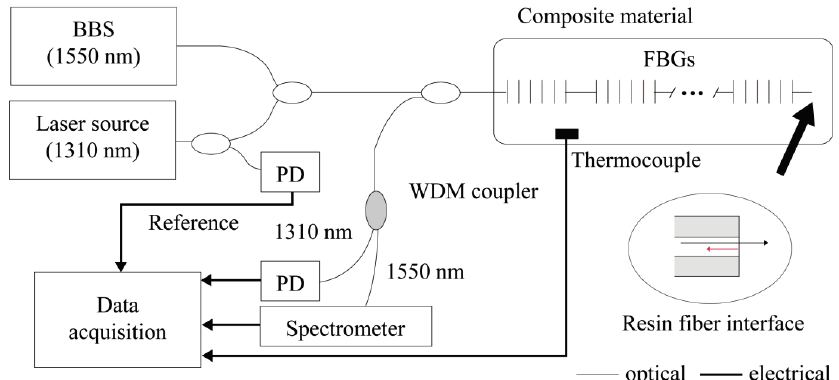
Figure 2. Schematic of cure monitoring system.